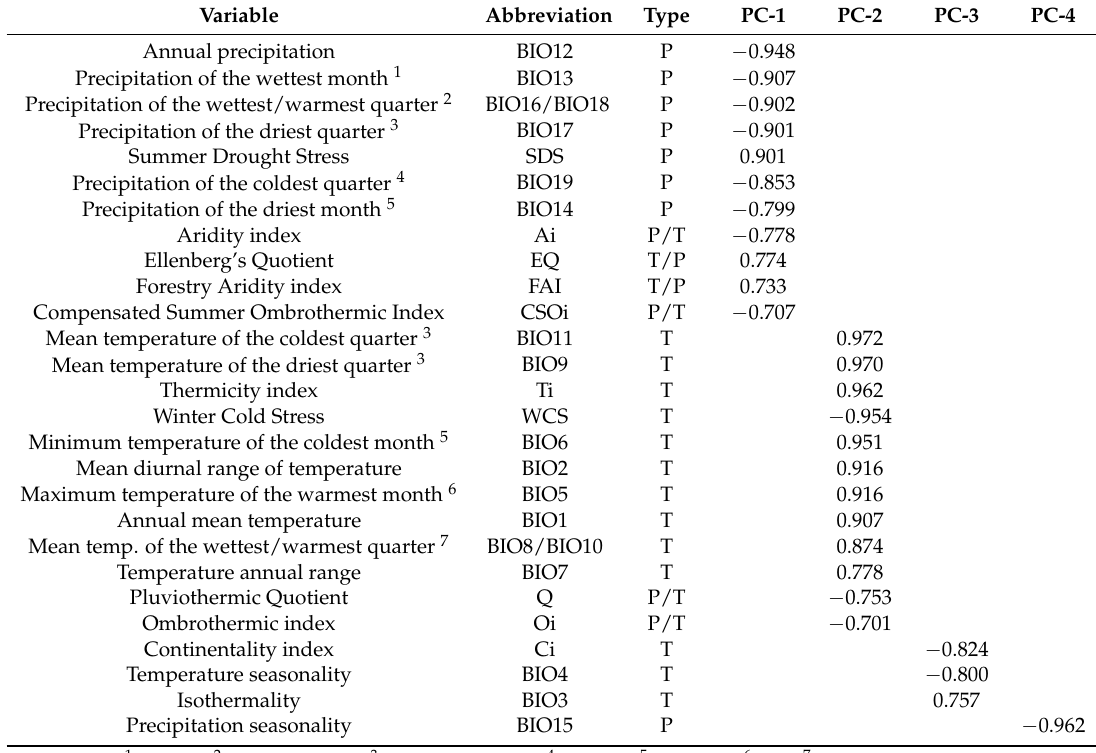
Table 1. Results of the exploratory factor analysis including 27 bioclimatic variables in relation to beech forests presence. Variables are listed in ascending order of principal components (PC-1; PC-2; PC-3; PC-4), and descending order of factor loadings (numbers) within a component. Abbreviation and type of variables are also indicated (P = precipitation, T = temperature, P/T or T/P =